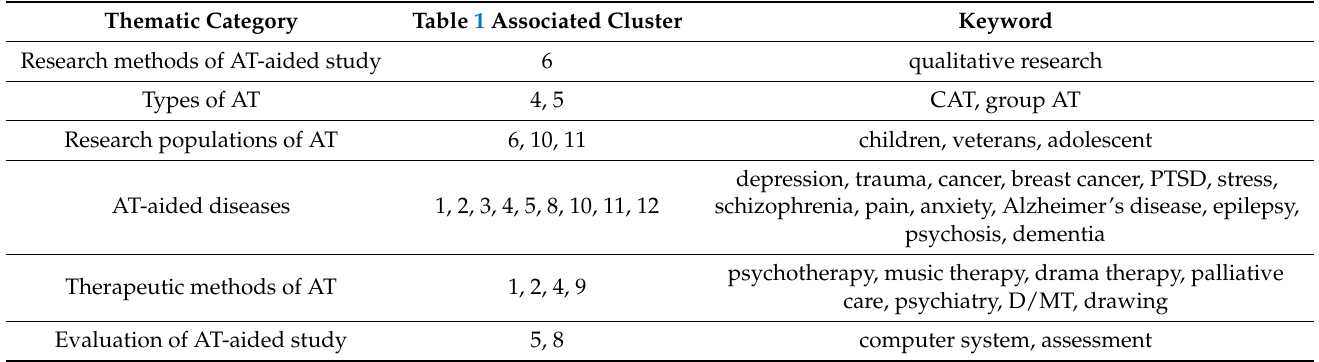
Table 2. Six thematic categories of AT-aided health and well-being (devised by the authors). Table 1 Associated